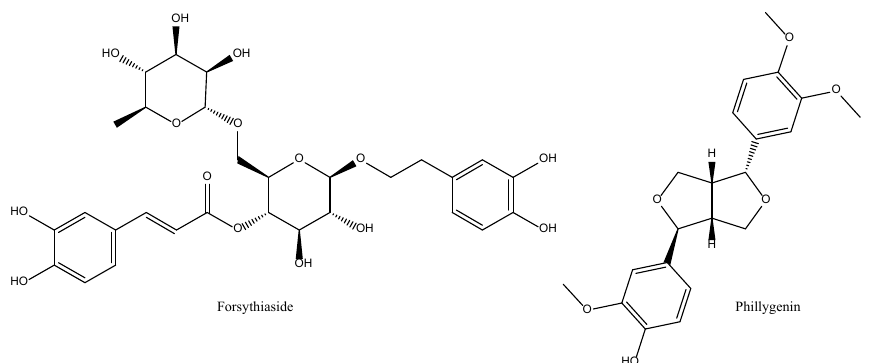
Figure 10. Bioactive anti-inflammatory (eicosanoid inhibition) and antioxidant principles from Forsythia suspensa .